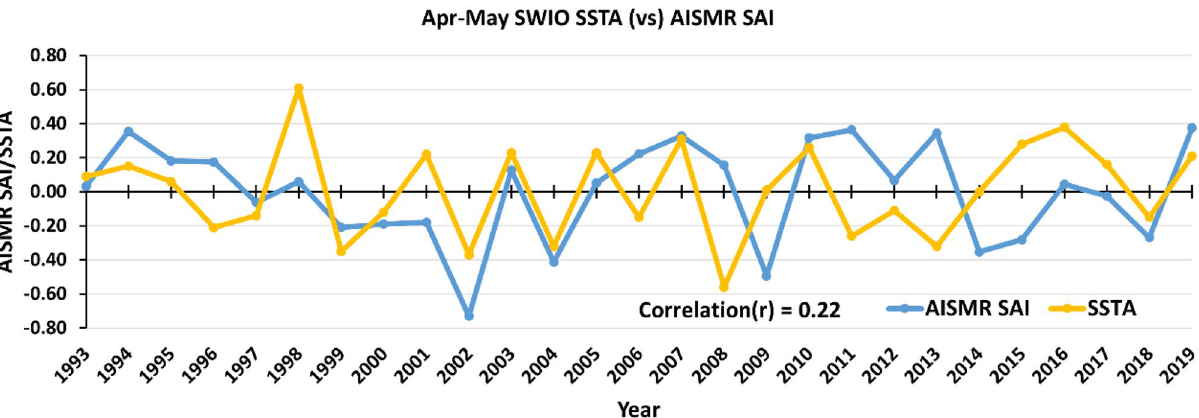
Figure 7. Time series of detrended Apr–May mean SSTA (°C, yellow) over SWIO compared with detrended AISMR SAI (blue). The figure is generated using Microsoft